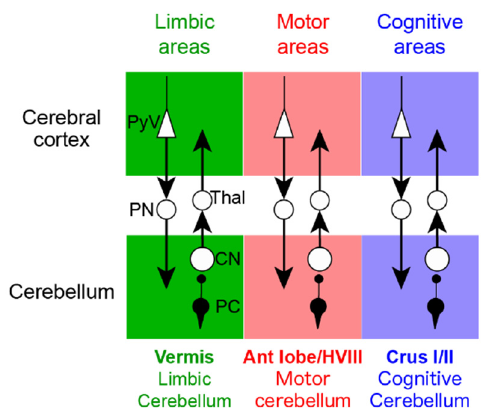
Figure 3. The parallel organization of the cerebro-cerebellar loops. The cerebellum contains anatomically separate and functionally distinct motor and nonmotor domains. CN: cerebellar nuclei cells; PC: Purkinje cells; PN: Pontine nuclei cells; PyV: Layer V Pyramidal cells; Thal: Thalamus.